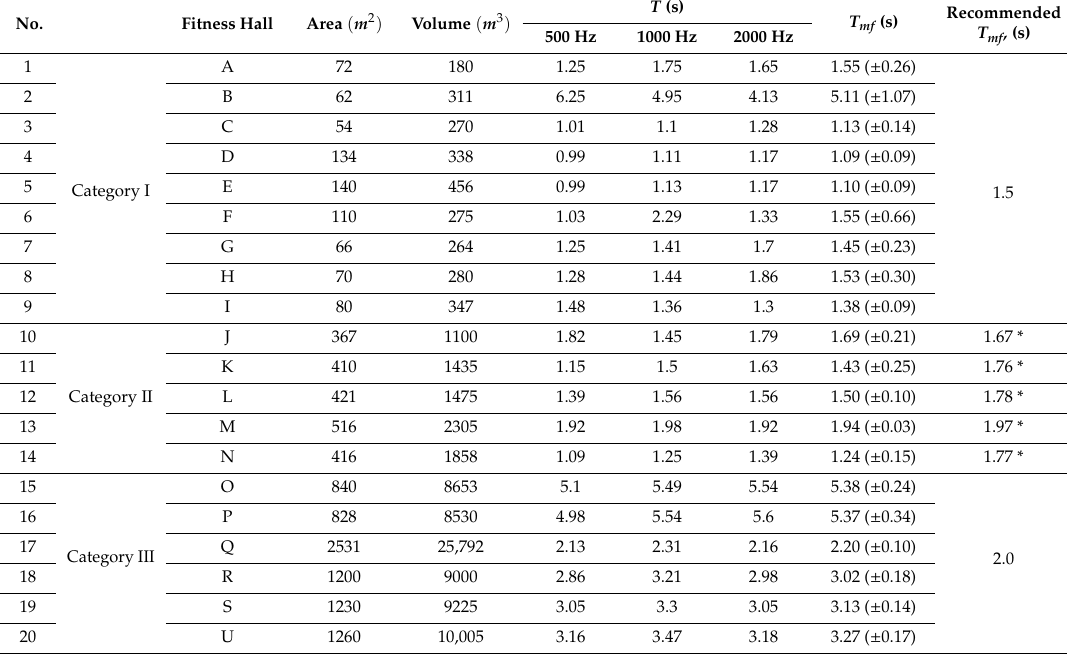
Table 6. Mid-frequency reverberation time (with SD) in indoor sports and gymnasium halls compared with recommended mid-frequency reverberation time ( T mf ) from BB [1].